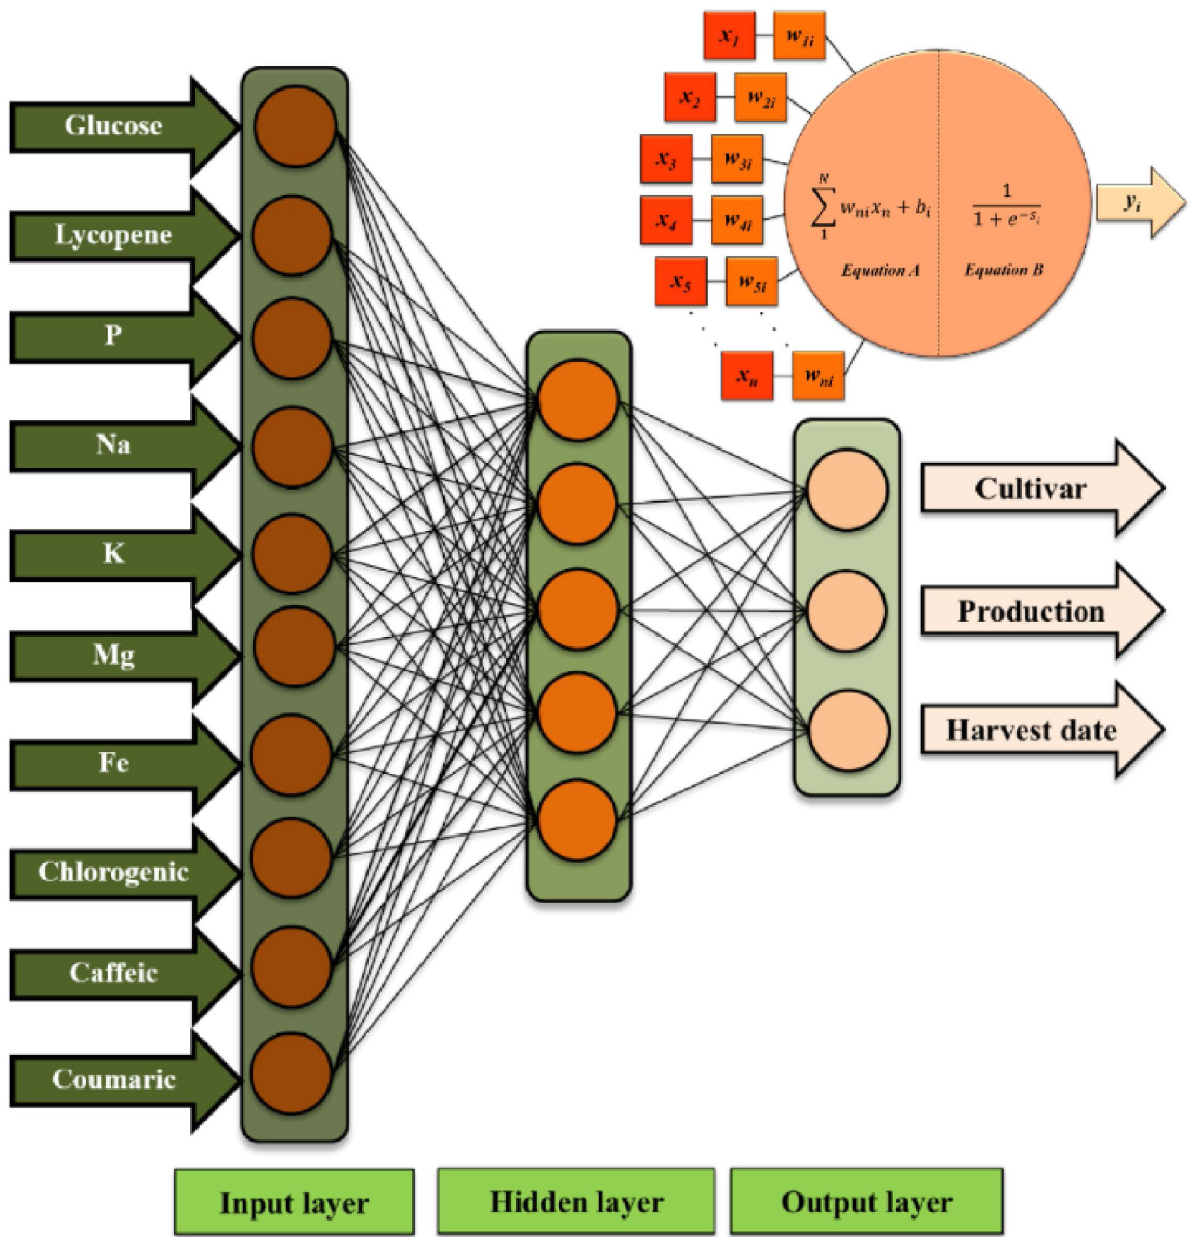
Fig 1. Diagram operational of an artificial neuron and sample diagram for an ANN 3 model with ten input neurons, five neurons in the intermediate layer and three output neurons, that ’ s, with a topology of